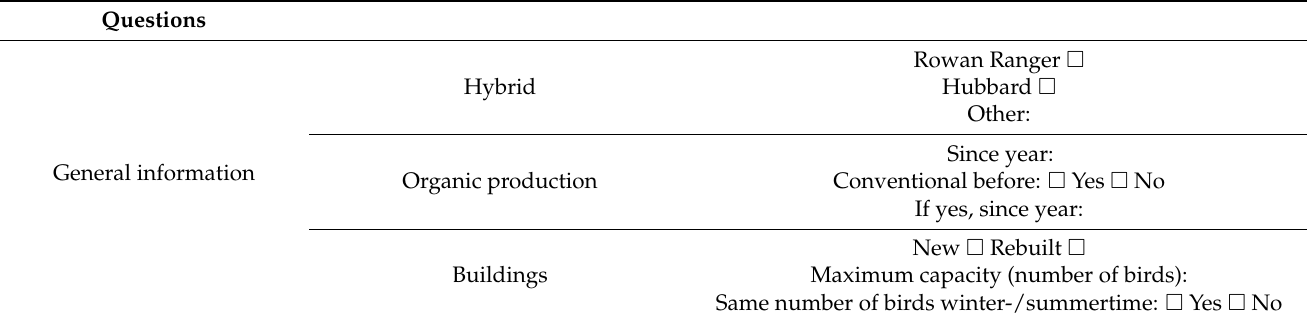
Table A1. Questionnaire used in interviews with farmers on Swedish organic broiler chicken